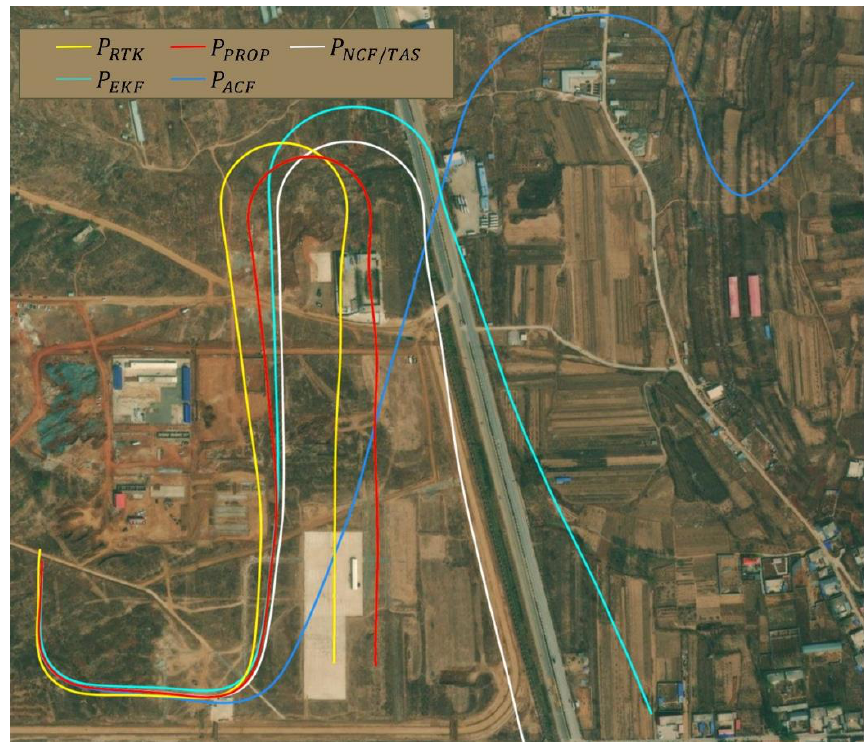
Figure 11. Comparison of 190 s long trajectories obtained from different algorithms, and what we proposed is the most accurate tracking.